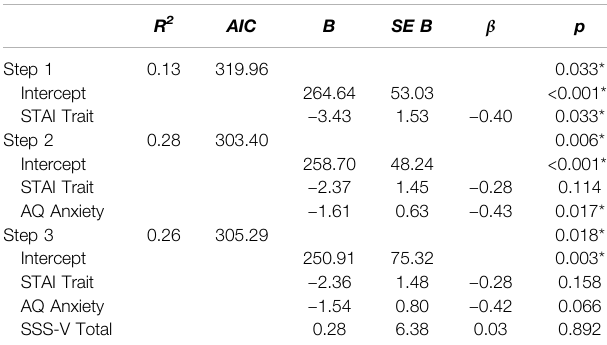
TABLE 2 | Summary of hierarchical regression analyses for psychometric questionnaire scores predicting time spent on open arms of the virtual EPM in study